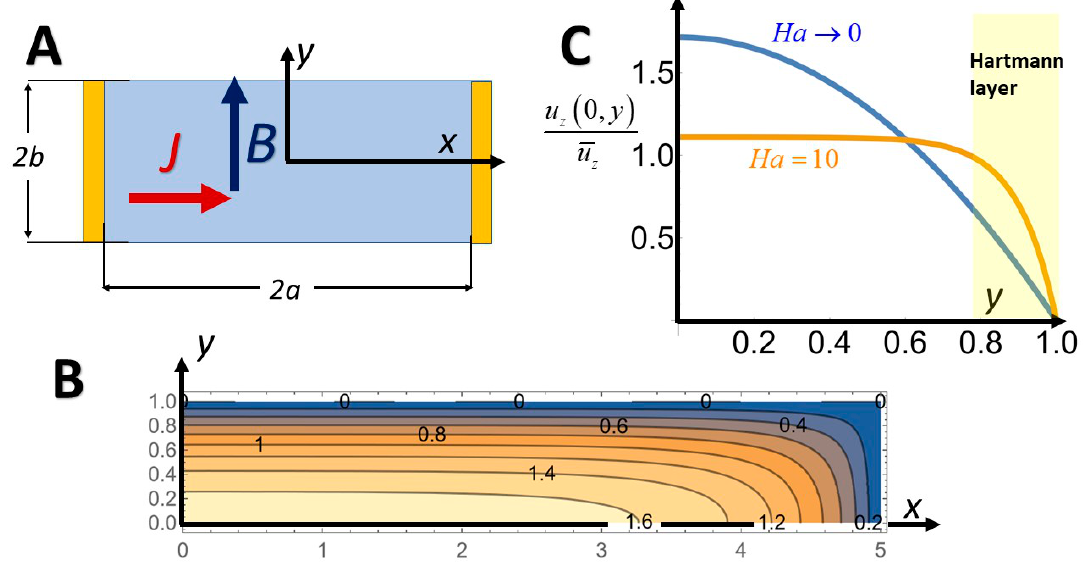
Figure 1. MHD flow in a long conduit with a rectangular cross-section 2 a × 2 b . The z-coordinate is directed into the paper. ( A ) Conduit’s cross-section. Current injecting electrodes form the conduit’s side walls ( x = ± a ). ( B ) Contour lines of the normalized axial velocity u z ( x , y ) / u z in the absence of induction (Ha → 0). ( C ) The normalized velocity profile u z ( 0, y ) / u z as a function of y/b when the Hartmann (Ha) number is small (blue, Ha → 0) and when Ha = 10 (gold). High Hartmann numbers are, however, uncommon but not impossible [5], in electrolytes.